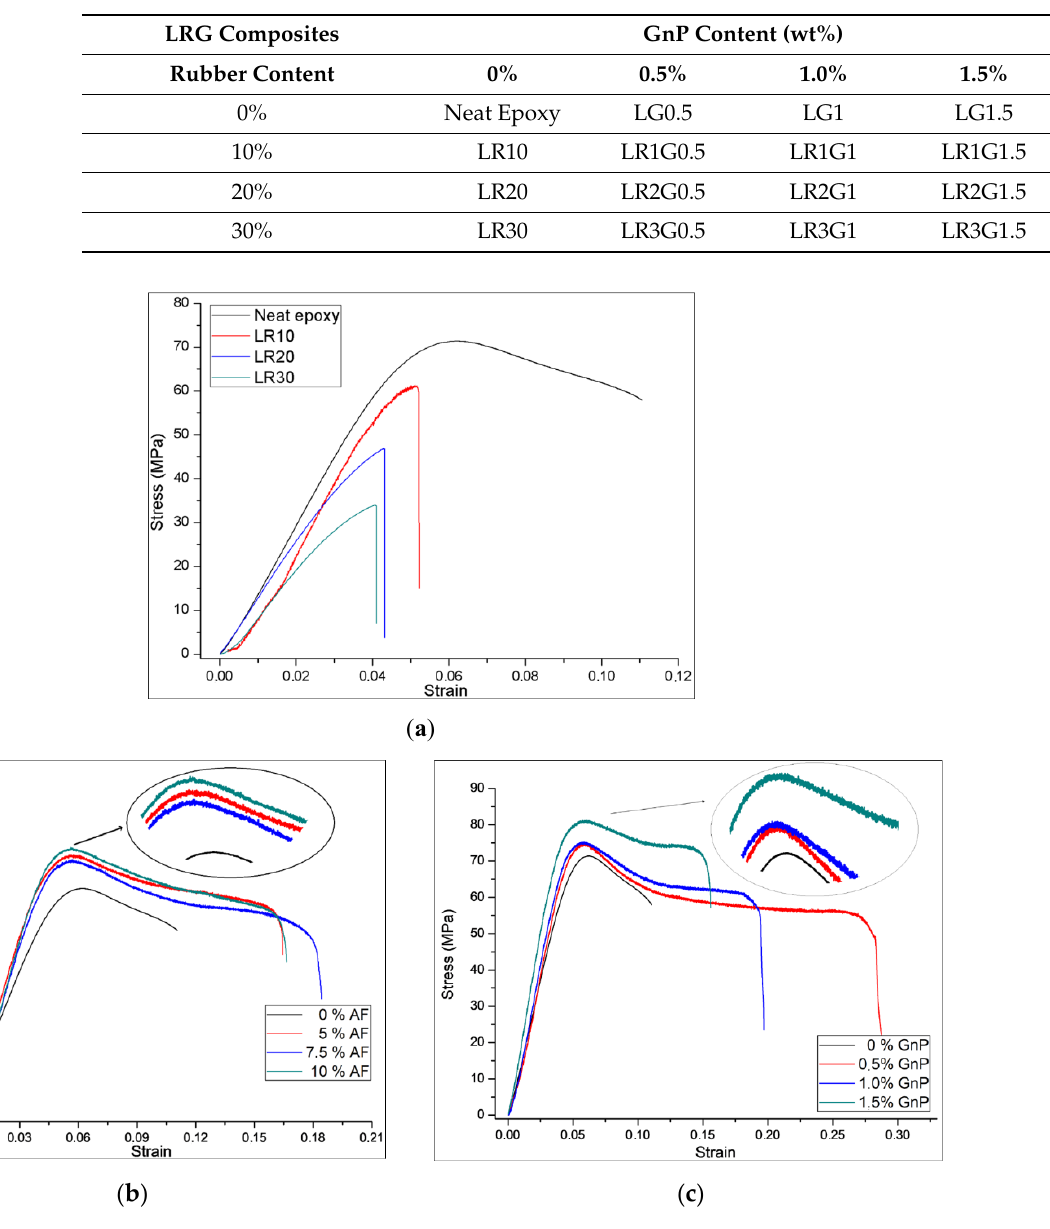
Table 9. Composition of the GnP reinforced composites [53].